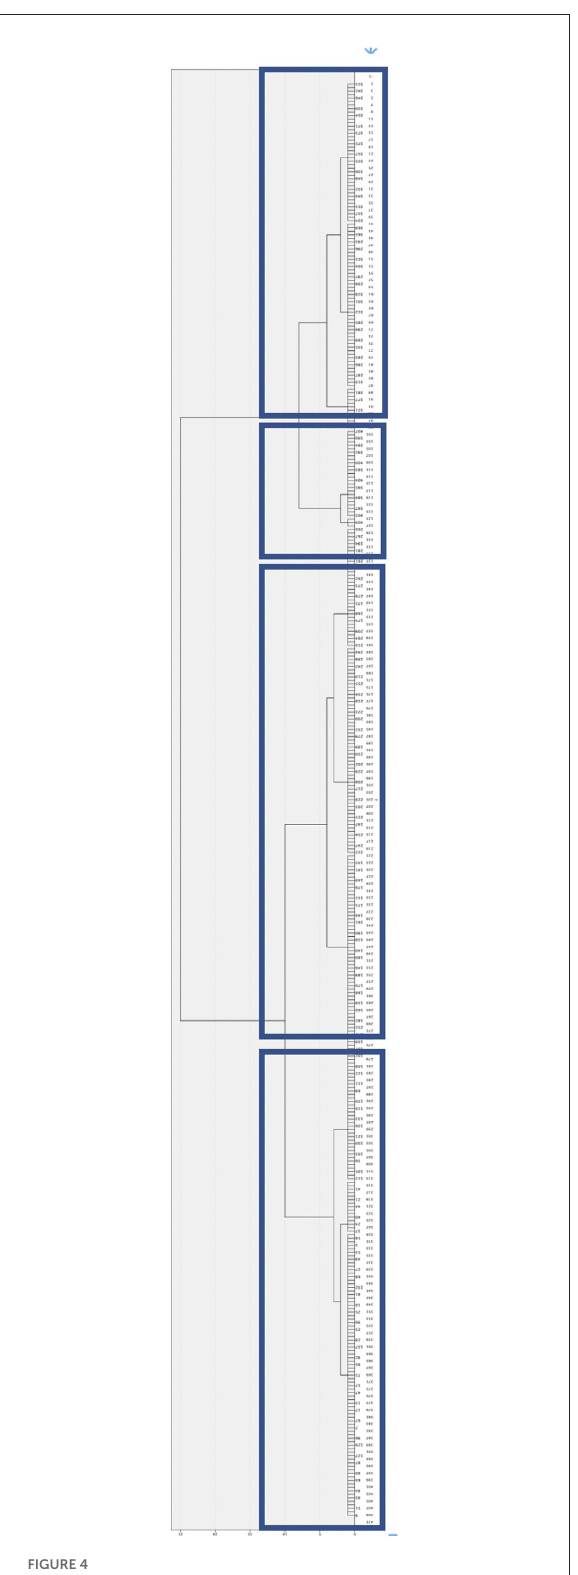
FIGURE4 Hierarchical cluster analysis dendrogram.